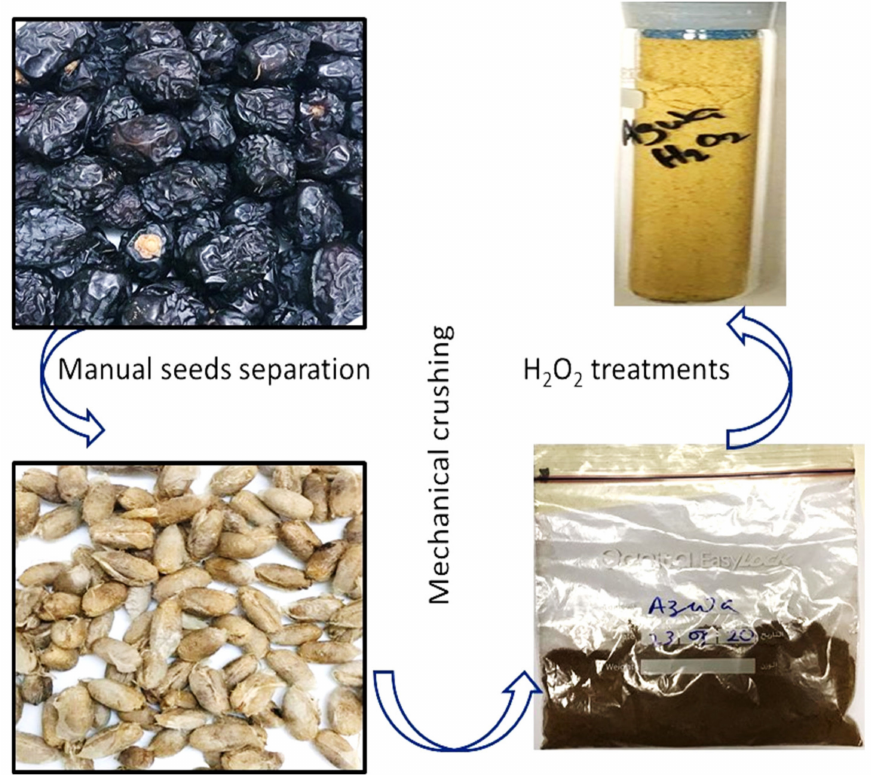
Figure 1. Ajwa dates, pits, and treated and untreated dates